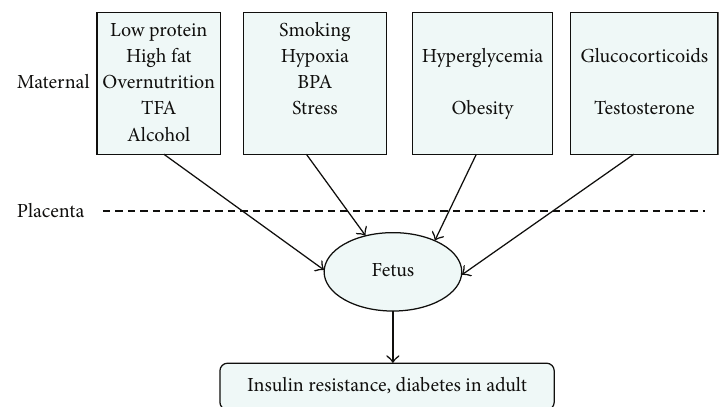
Figure 1: Prenatal factors mentioned in recent years that might correlate with insulin resistance and/or T2DM. Data from human and animal studies have shown that malnutrition or overnutrition, metabolic disorders, exposure to hypoxia, some chemicals and hormones, and unhealthy lifestyle such as smoking and alcohol drinking during pregnancy might predispose detrimental long-term effects on offspring, leading to increased risk of insulin resistance or T2DM. TFA: transfatty acids; BPA: biophenol A.